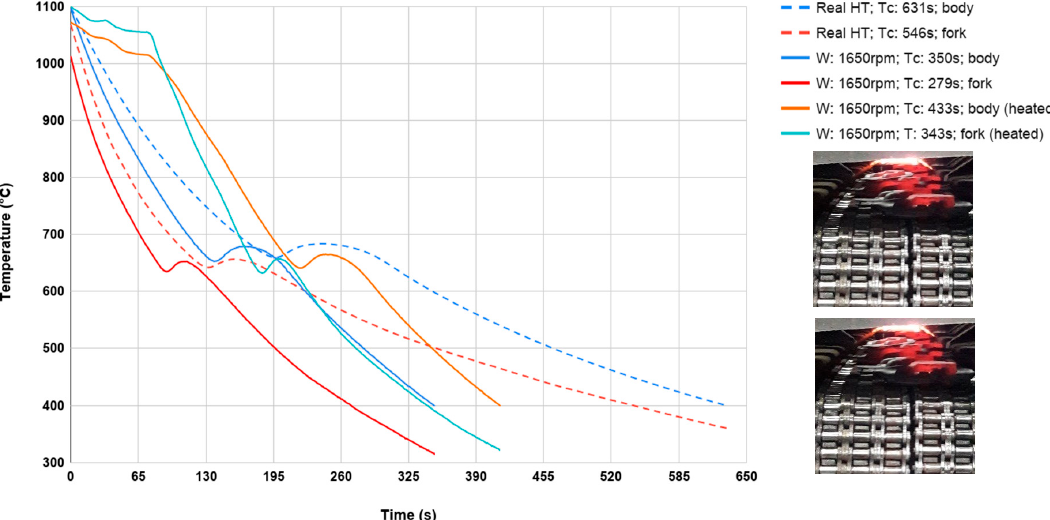
Figure 14. Cooling course of a yoke forging within the scope of 1100–400 °C in the function of time for different ventilator speeds (pictures from industrial cooling process).